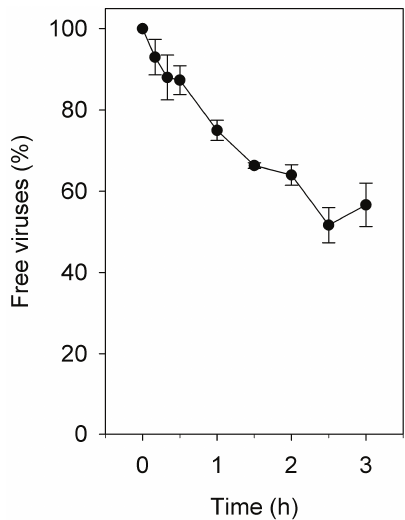
Figure 1. Adsorption efficiency of His2 to Haloarcula hispanica cells at 37 °C with aeration. The number of unadsorbed viruses was determined by plaque assay. Linear regression was calculated for 0–150 min ( r 2 = 0.97). The last point (180 min) shows the effect of release of the first progeny viruses (see also Figure 3D).